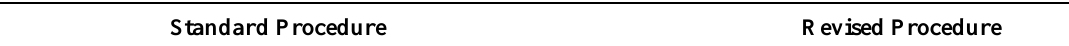
Table 1. Revised practice instructions for adaptive management planning